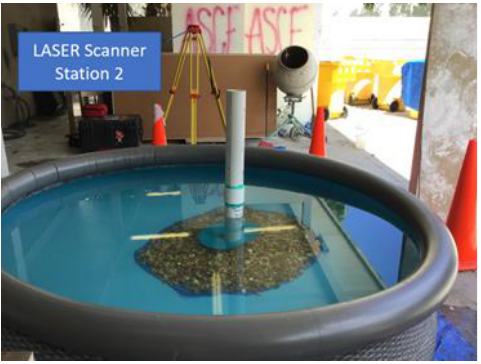
Figure 7. Scan station two in operation [35,36] (used with permission).